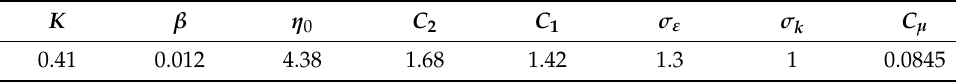
Table 3. Coefficients for RNG k- ε turbulent model